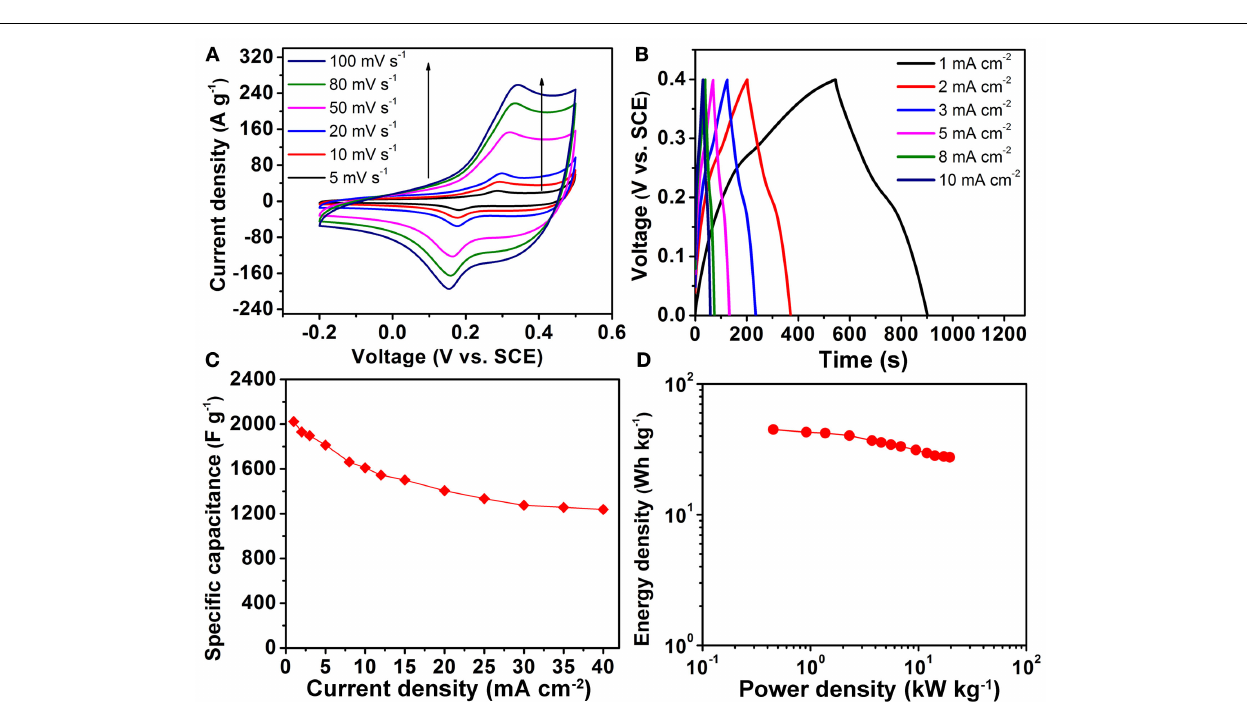
Frontiers in Energy Research |